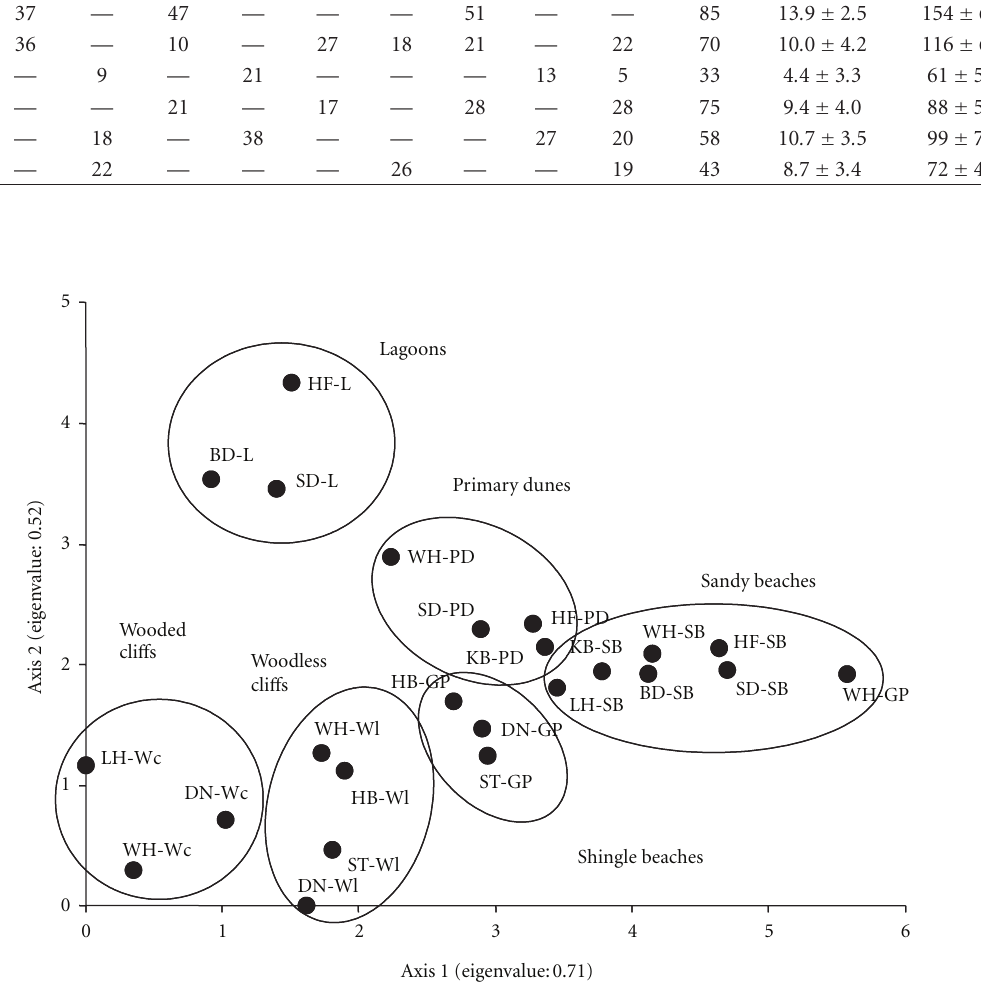
Figure 2: Results of the detrended correspondence analysis showing the separation of the 6 habitat types along the first two